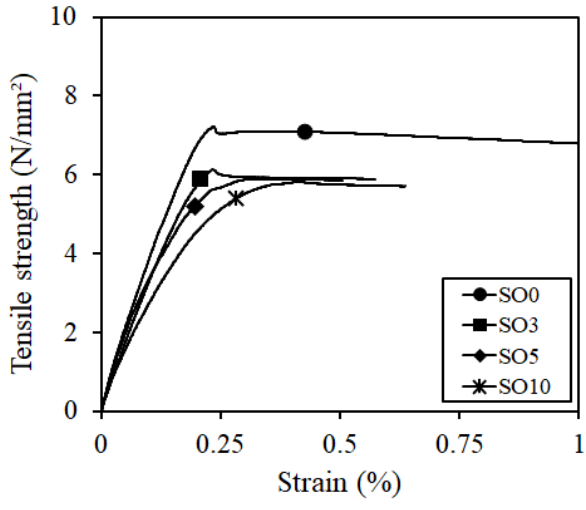
Figure 5. Tensile strength.